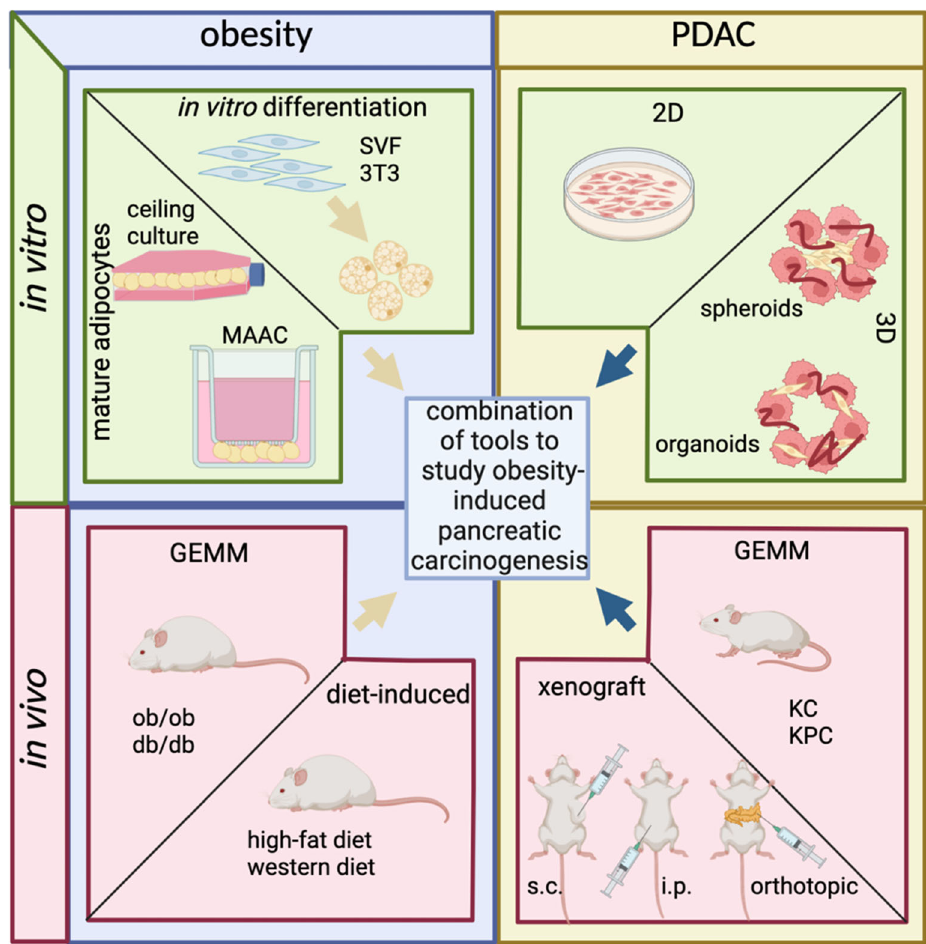
Figure 1. Overview of in vitro and in vivo models of obesity and PDAC. Preadipocytes (blue) can be differentiated in vitro into adipocytes (yellow) with similar characteristics compared to in vivo rose adipocytes. Otherwise, mature adipocytes can be isolated out of the fat tissue and cultured for a couple of days (ceiling culture) or up to two weeks (membrane mature adipocyte aggregate cultures = MAAC) until dedifferentiation. Pancreatic cancer cell lines (red) or isolates can be cultured in 2D and 3D